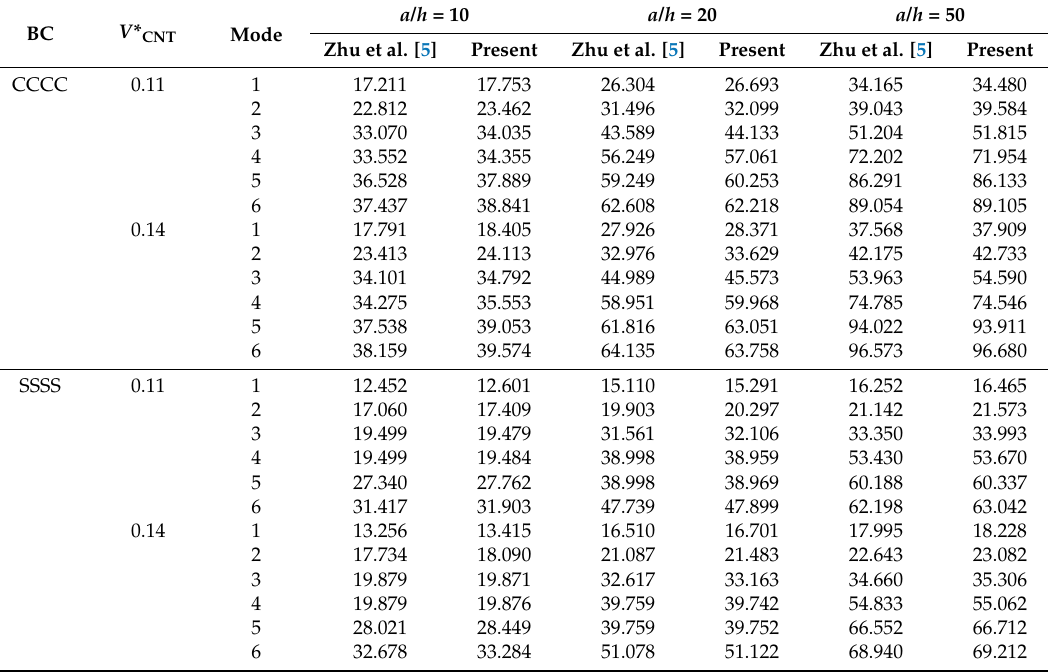
Table 6. Comparison study of first six non-dimensional frequency parameter of FG-V CNT-reinforced composite plate.